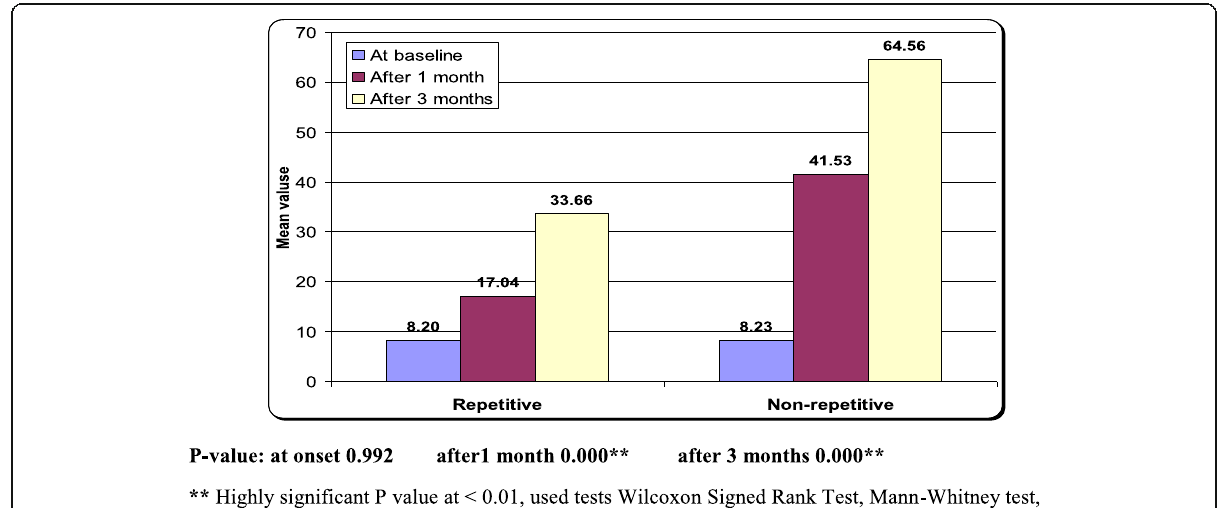
Fig. 1 Comparing KAAT score at follow-up between aphasia with repetitive disorder and without repetitive disorder